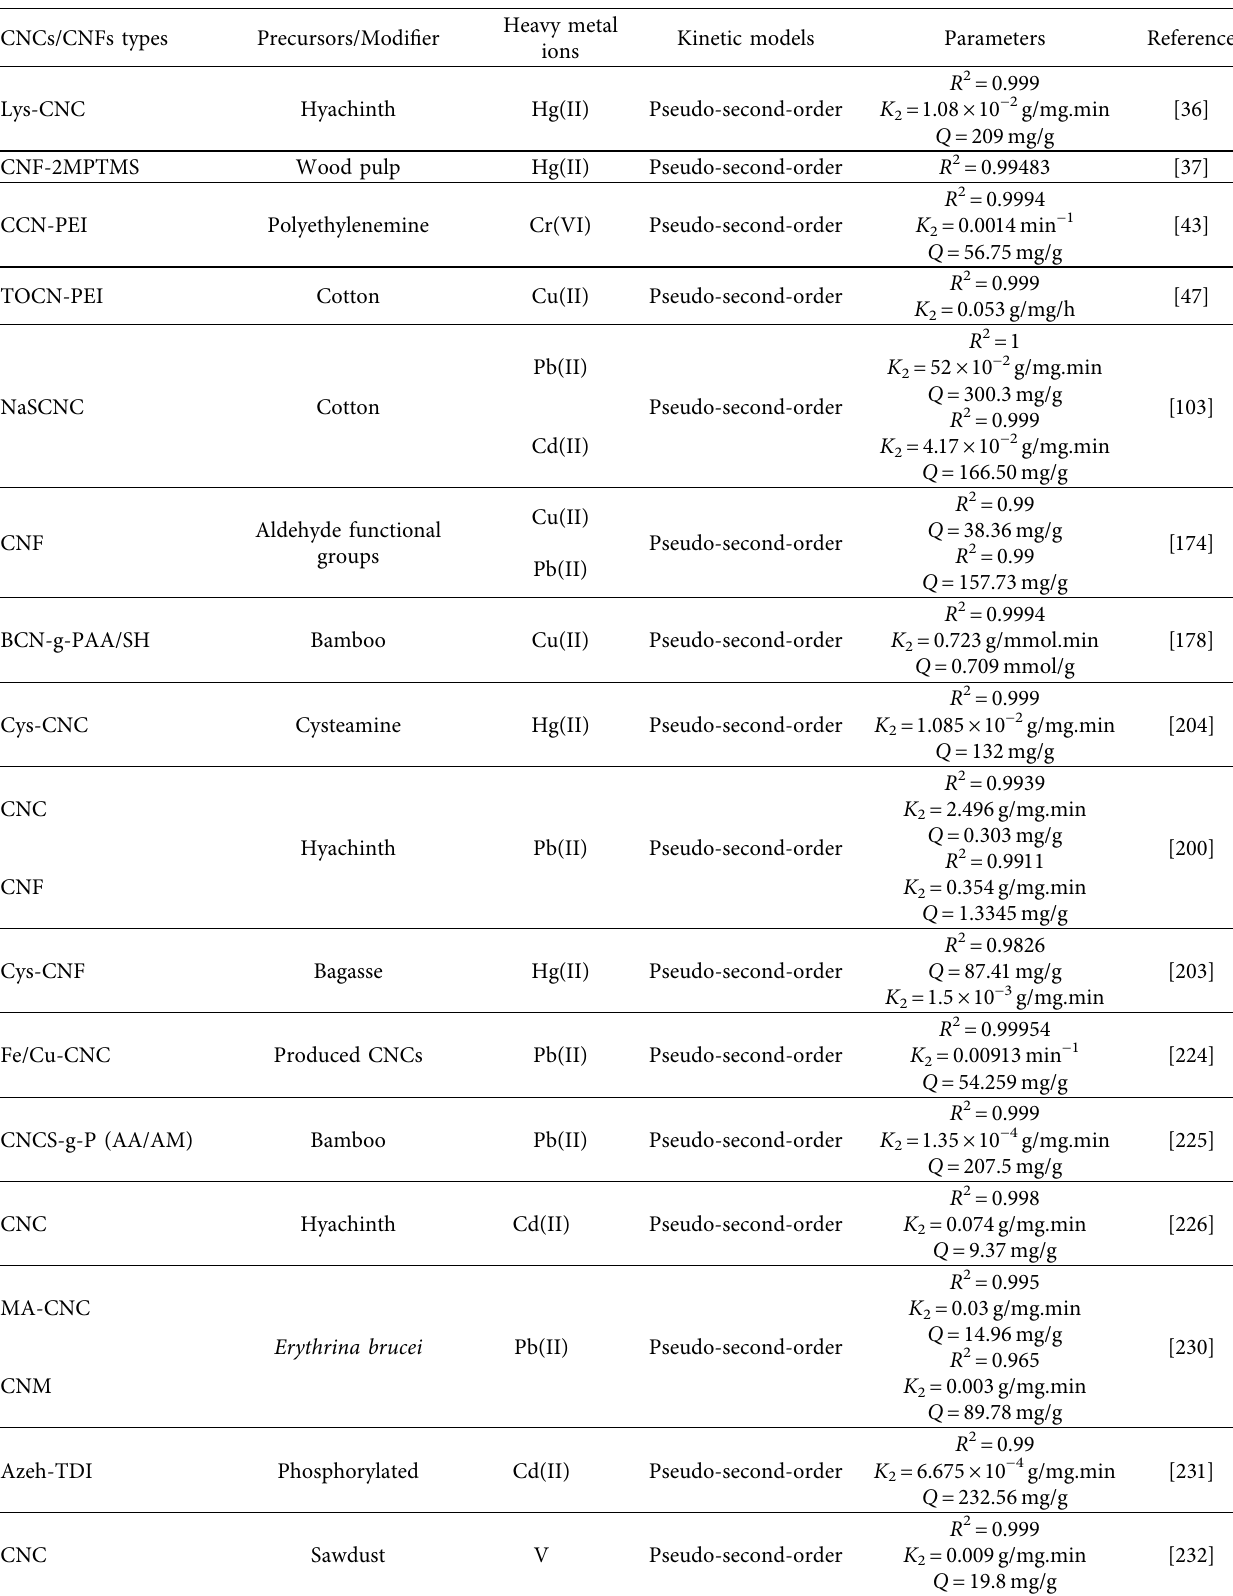
Table 7: Te adsorption kinetic models of various modifed CNCs and